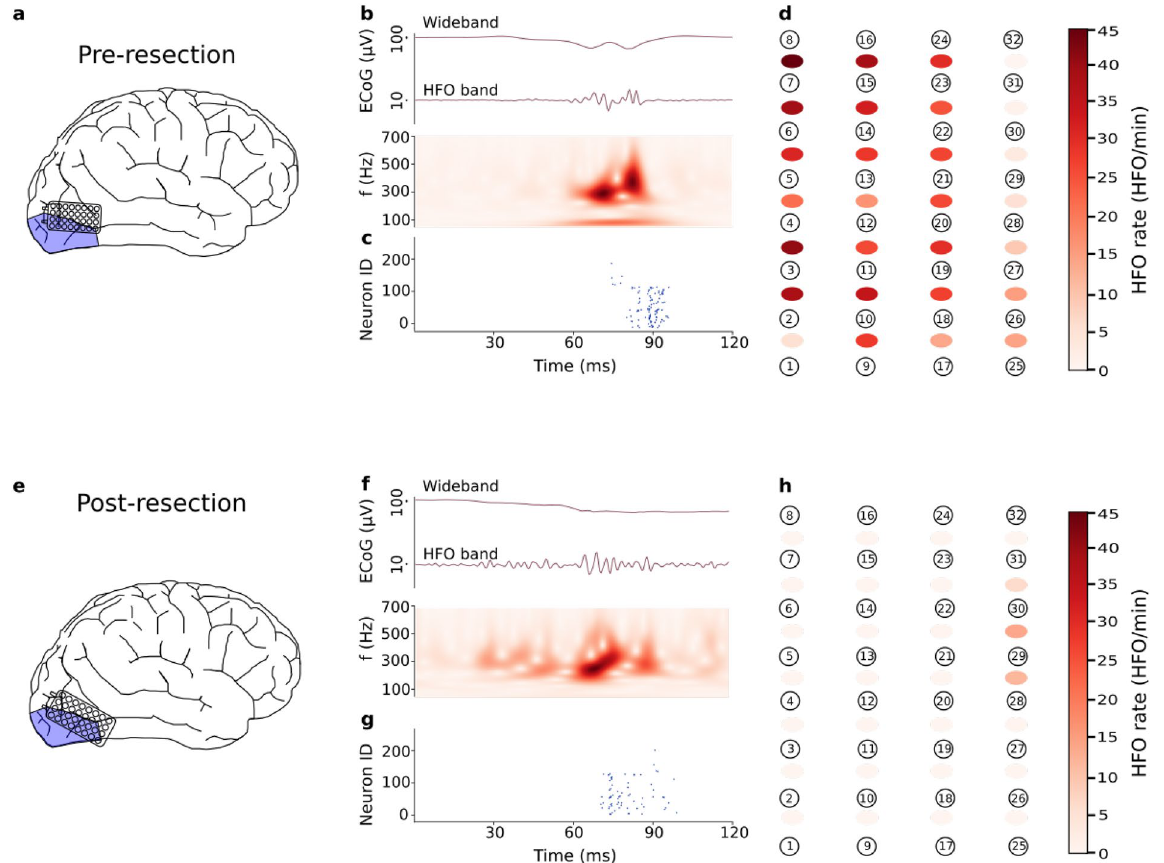
Figure 3. Intraoperative ECoG recording and HFO detection in Patient 6. (a) Position of the high-density grid electrode before resection. (b) Example of an HFO in the pre-resection ECoG, wideband and filtered in HFO band (250–500 Hz), and the time-frequency spectrum. (c) Firing of SNN neurons indicate the occurrence of an HFO. (d) Pre-resection HFO rates for each recording channel. (e) Electrode position after resection. (f) Example of an HFO in the post-resection ECoG. (g) Firing of SNN neurons indicate the occurrence of an HFO. (h) Post-resection HFO rates for each recording channel. In 4 channels (28–29, 29–30, 30–31, 1–2), the HFO rate exceeded 1 HFO/min. The occurrence of these residual HFOs “predict” poor seizure outcome. Indeed, the patient suffered from recurrent seizures (ILAE